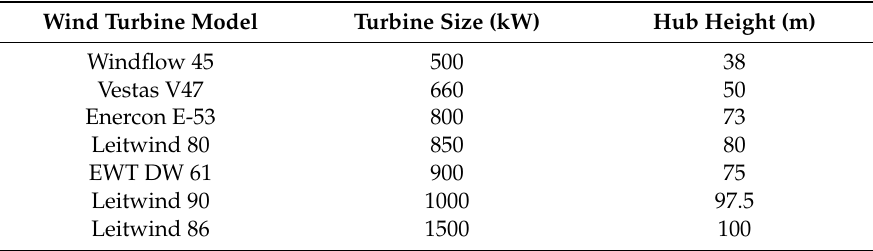
Table 1. List of the investigated wind